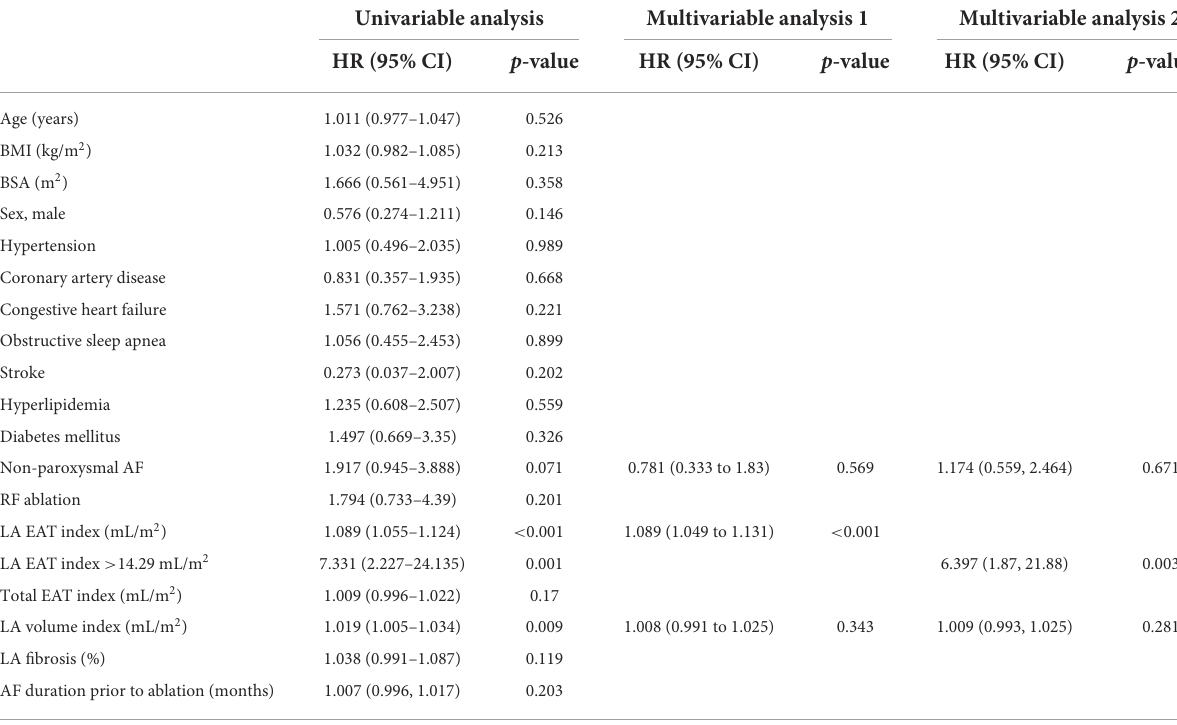
TABLE 2 Univariable and multivariable predictors of arrhythmia free survival with a Cox regression. Univariable analysis Multivariable analysis